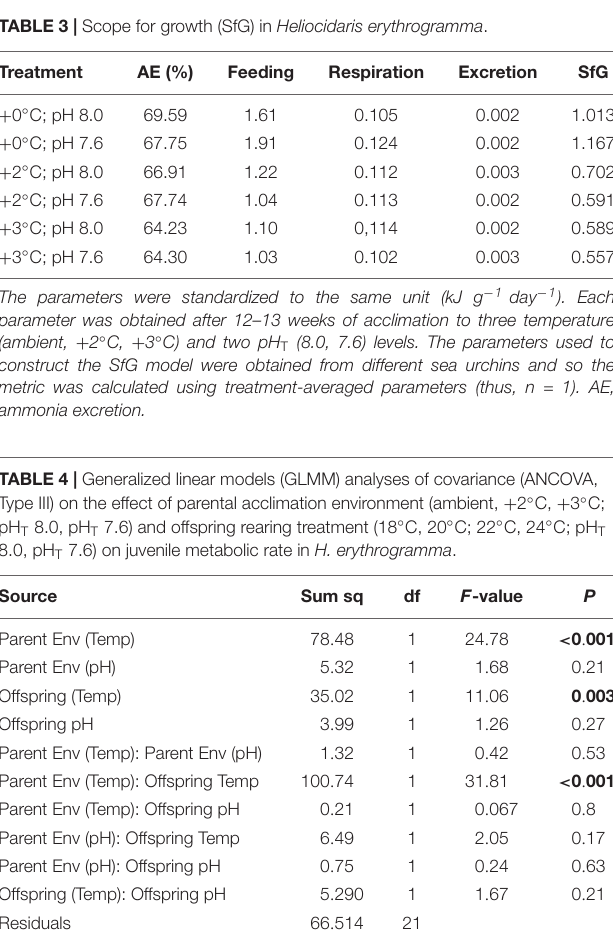
known to entrain gonad development in H.